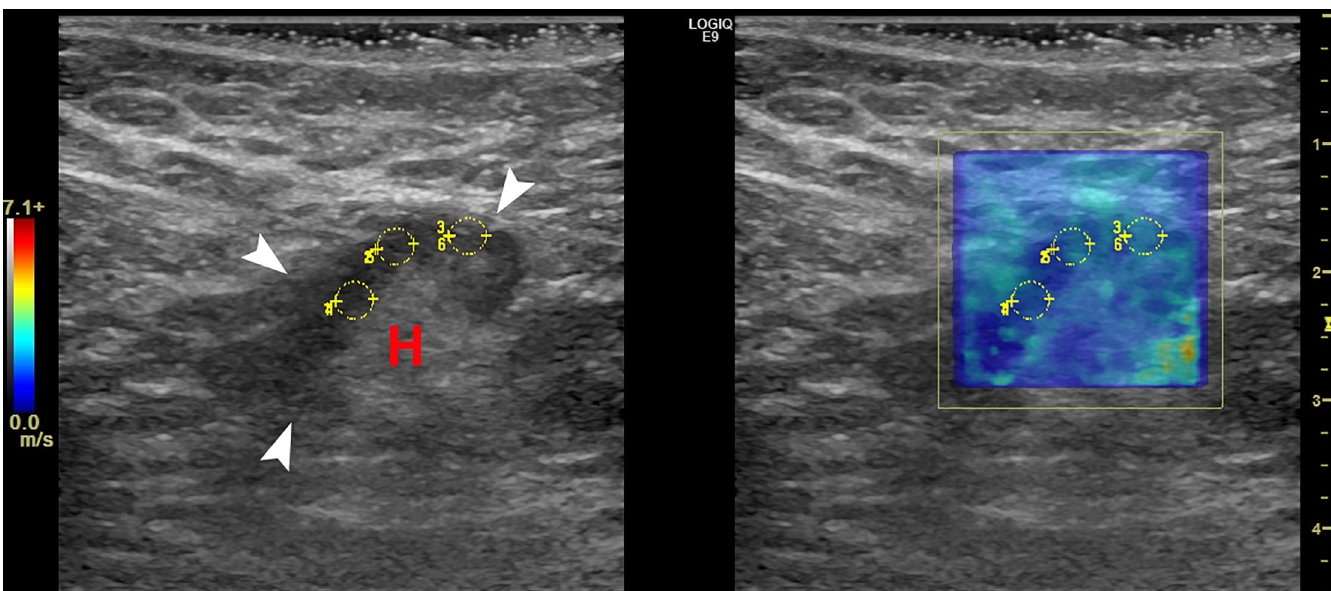
Fig 4. Left axillary B-mode (left) and shear wave speed map (right) images in a 45-year-old woman with invasive mammary carcinoma in the left breast. The US image shows 1 lymph node (white arrows) with mild cortical thickening measuring 4.6-mm and visible hilum (H). The elasticity results calculated from the average of the 3 ROIs (yellow) were E mean = 10.1-kPa and E max = 15.9-kPa. FNA biopsy results showed a mixed lymphoid population, most consistent with a reactive lymph node. Furthermore, the patient underwent SLN biopsy with negative results.